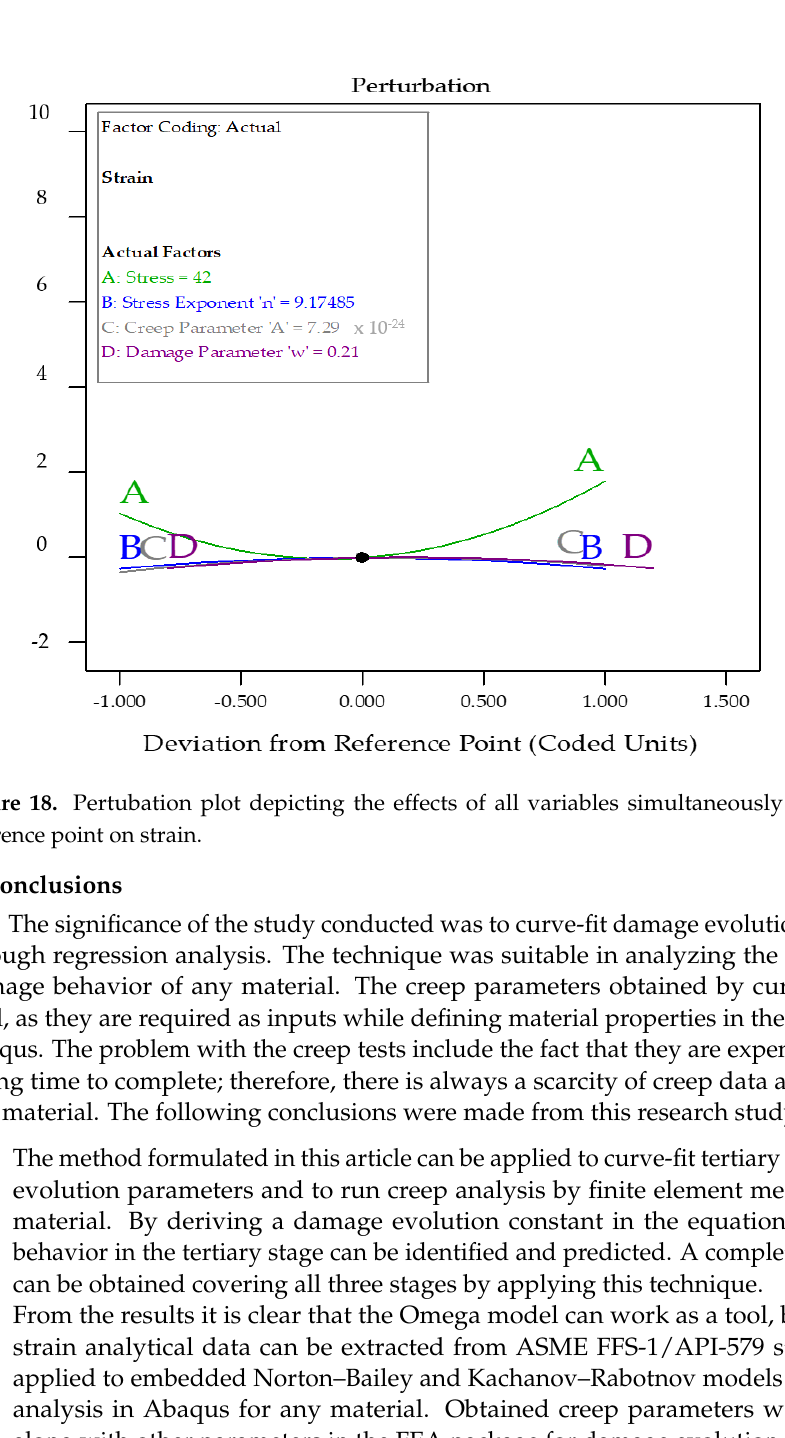
24 of 29 Figure 17. Optimization criteria for factors and response.